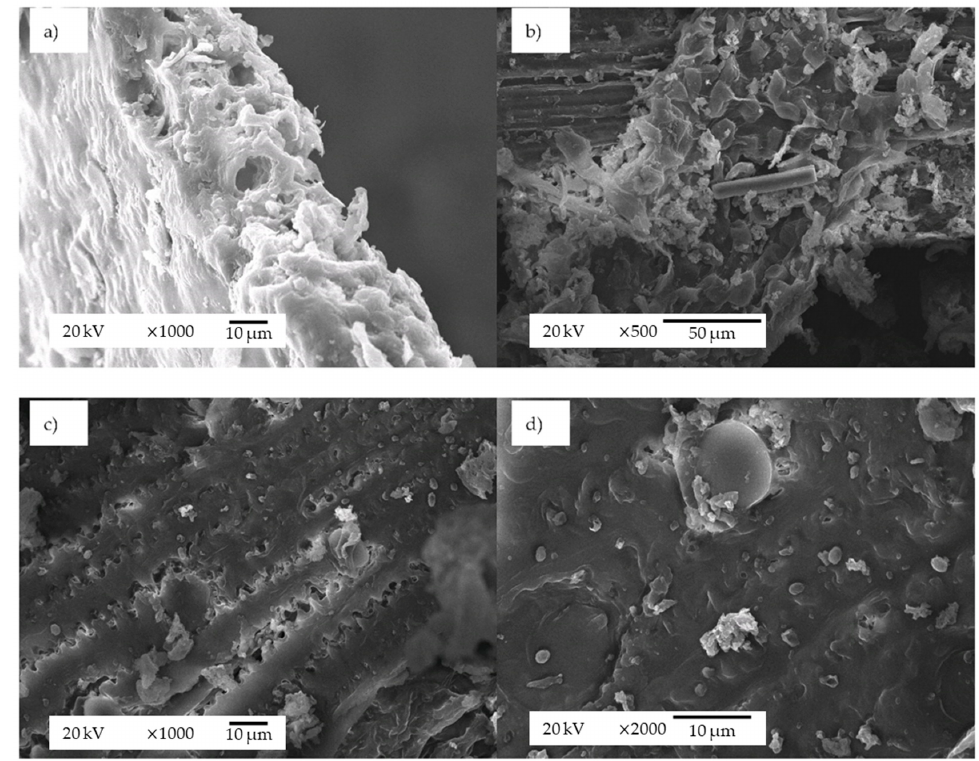
Figure 2. Scanning electron micrographs (SEM) of ( a ) raw BSG (1000×), ( b ) subW-pretreated BSG (500×), ( c ) subW-pretreated BSG (1000×), and ( d ) subW-pretreated BSG (2000×). The WRV of the raw BSG was 405 ± 10% and it increased after the subcritical water pretreatment until 527 ± 4%. The increase in the WRV can be attributed to the xylan removal during the pretreatment [18]. All these chemical and structural changes in the pretreated solid can facilitate the enzymatic hydrolysis of subW-pretreated lignocellulose [24].